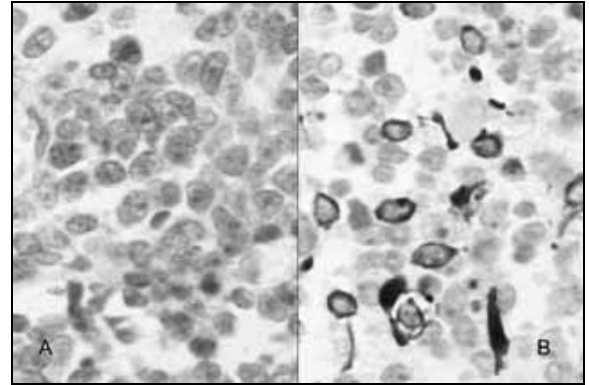
Figura 4 – Aumento de 400 vezes. A: imuno-histoquímica mostrando reatividade para WT-1; B: imuno-histoquímica mostrando reatividade para desmina, em padrão dot-like